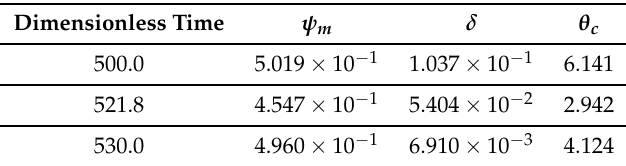
Figure 4. Dots indicates the mean temperature of eight probes, ψ , solid line refers to temperature fitted by Equation (9). Three time instants are considered: ( a ) Time = 500; ( b ) Time = 521.8; ( c ) Time = 530. Table 1. Parameters values of the fit function ψ ∗ at three time instants. The time (T) is adimensionalized by i means of the free fall velocity and the height of the cylindrical